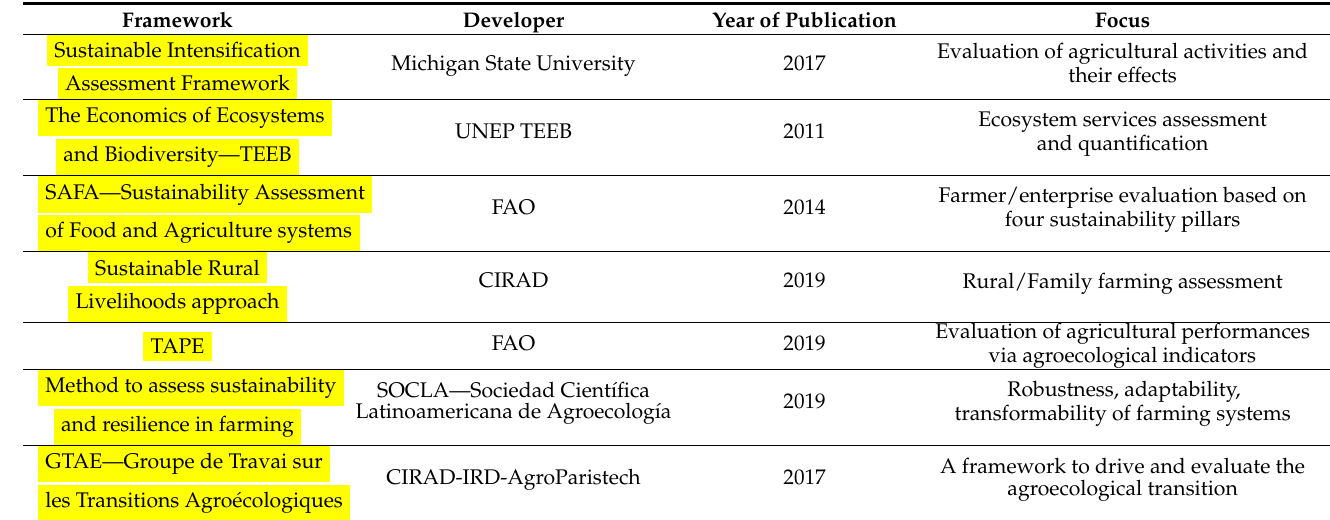
Table 1. Principal frameworks used to evaluate sustainability in agriculture